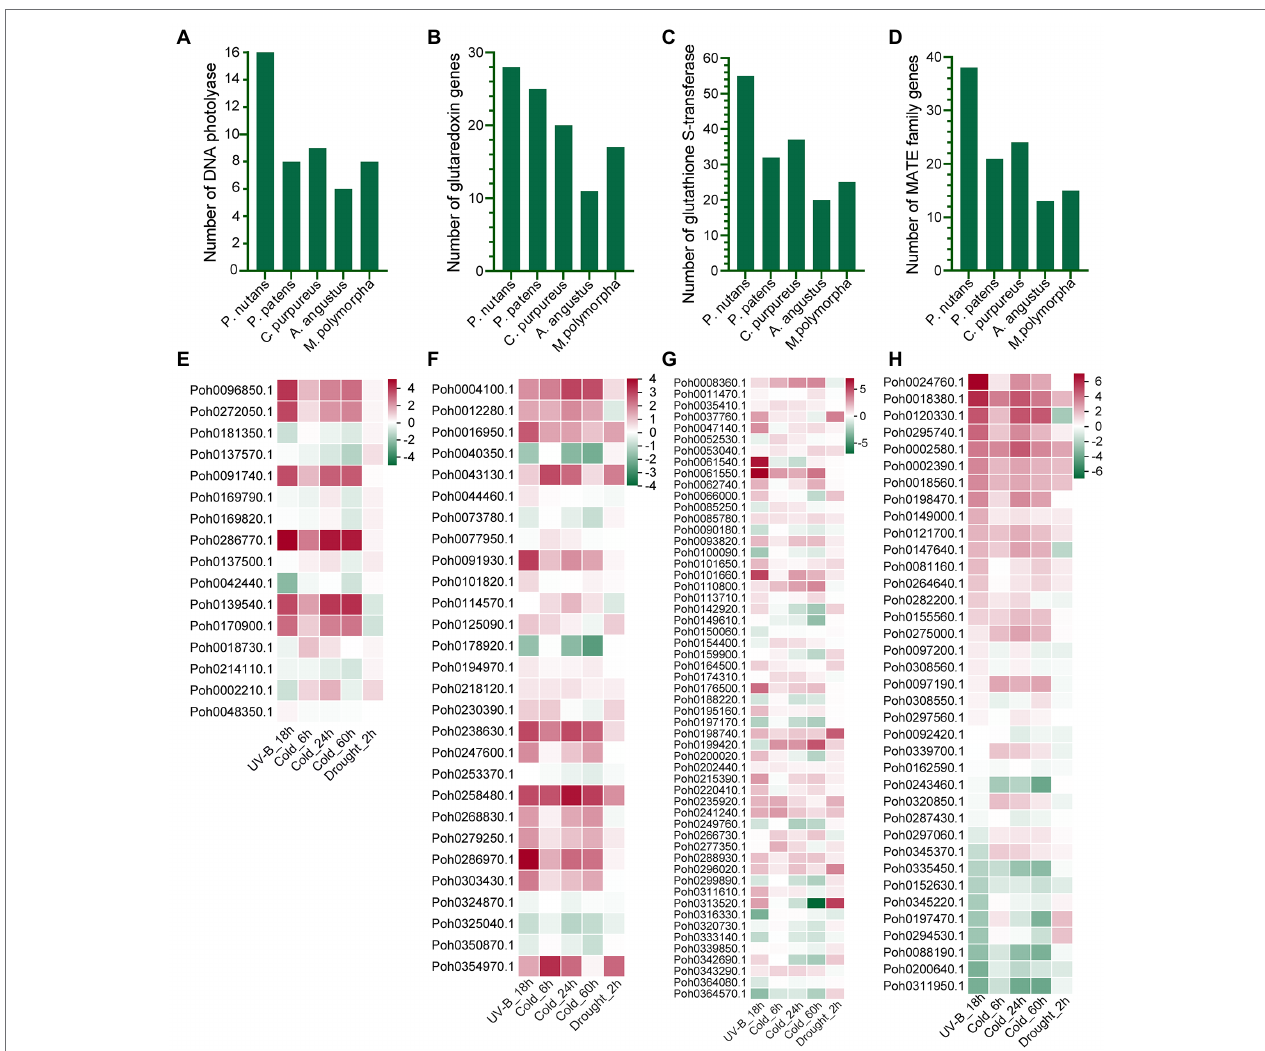
FIGURE 4 | The gene families related to oxidative stress were expanded and upregulated under various abiotic stresses. Gene families of DNA photolyase (A) , glutaredoxin (B) , glutathione S-transferase (C) , and protein detoxification with of MATE domain (D) were expanded in the P. nutans genome. Genes encoding DNA photolyase (E) , glutaredoxin (F) , glutathione S-transferase (G) , and protein detoxification with MATE domain (H) were markedly upregulated under UV-B radiation, cold, and drought stresses detected by transcriptome